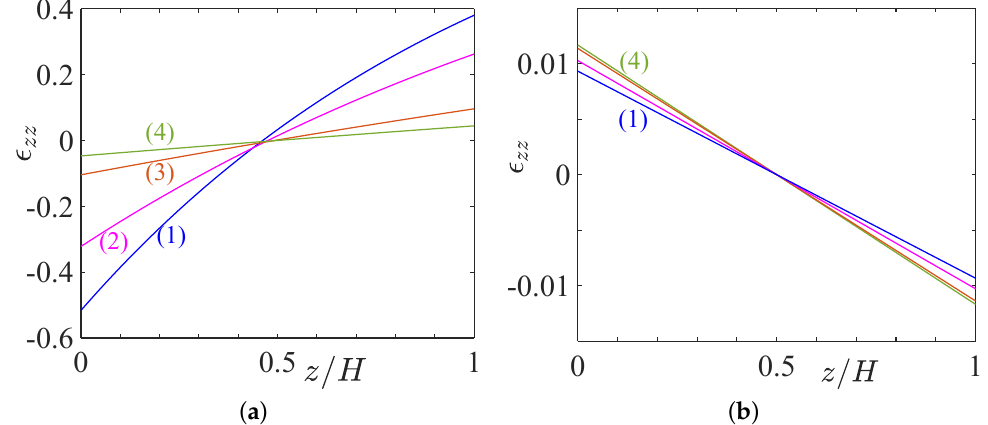
Figure 2. ( a ) Illustration of the strain (cid:101) zz induced by the gravity combined with a temperature gradient for different values of κ , Λ and Ψ : (1) ( κ , Λ , Ψ ) = ( 0.0204,1.092,0.849 ) , (2) ( 0.0340,1.652,1.416 ) , (3) ( 0.102,4.477,4.247 ) , (4) ( 0.204,8.723,8.495 ) . ( b ) The strain (cid:101) zz induced only by a temperature gradient. (1) χ = 0.0187, (2) χ = 0.0206, (3) χ = 0.0228 and (4) χ = 0.0234.